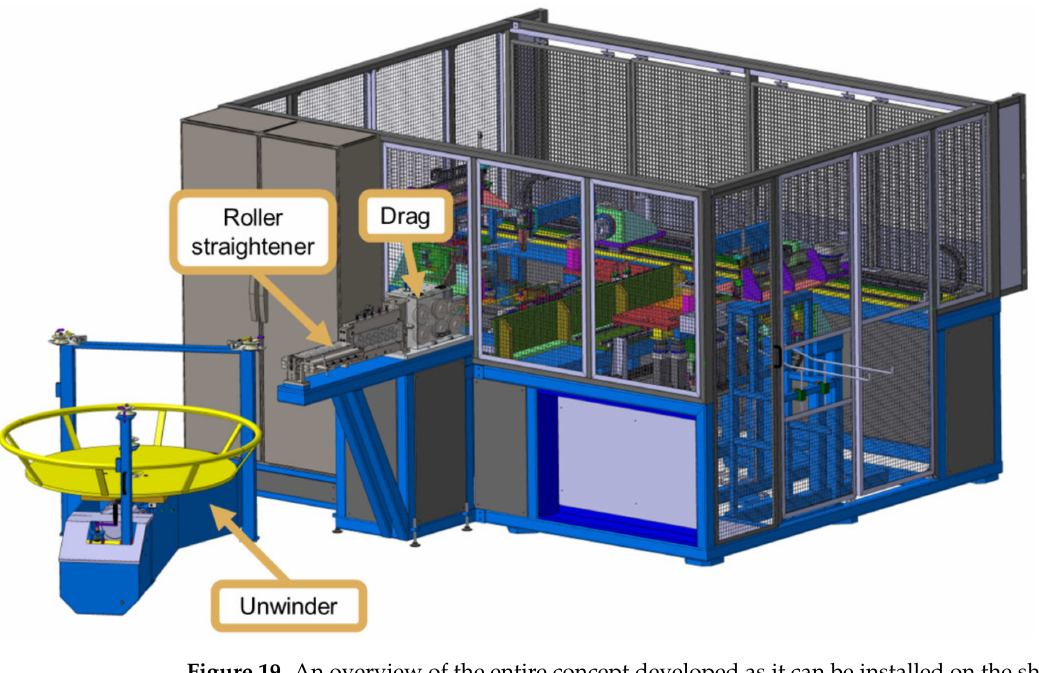
Figure 19. An overview of the entire concept developed as it can be installed on the shopfloor.